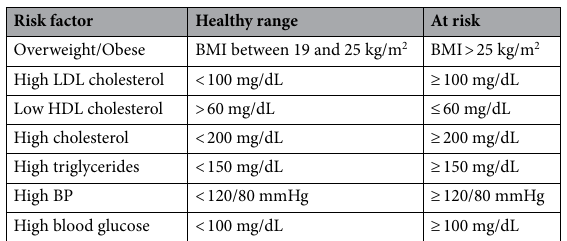
Table 1. Cutoff values of cardiometabolic risk factors. BMI body mass index, BP blood pressure, LDL low- density lipoprotein, HDL high-density lipoprotein.